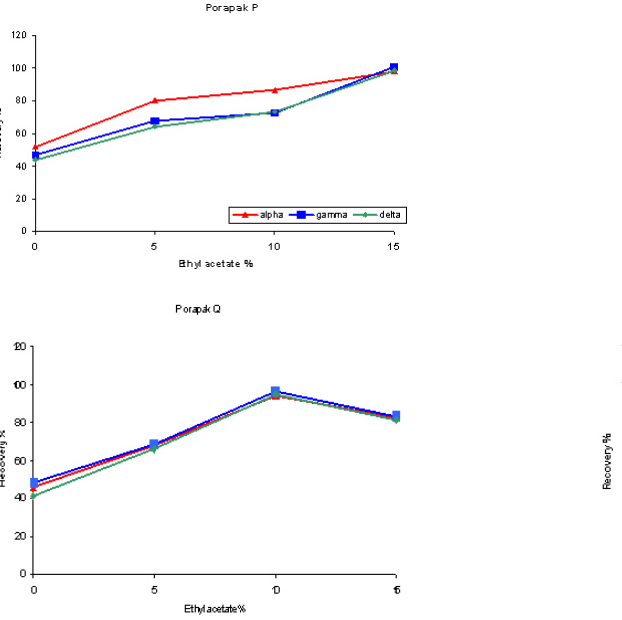
Figure 1. Influence of ethyl acetate addition on tocopherols recovery.